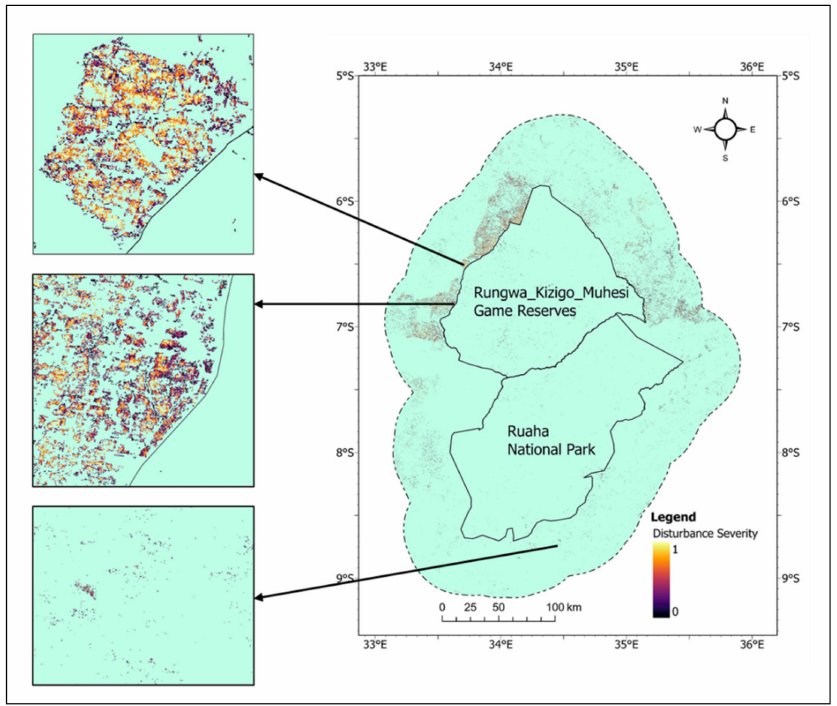
Figure 8. Disturbance severity in and around the Ruaha–Rungwa landscape. Magnifications of the prevalent regions of savannah conversion in the RKMGR and in the surroundings of the